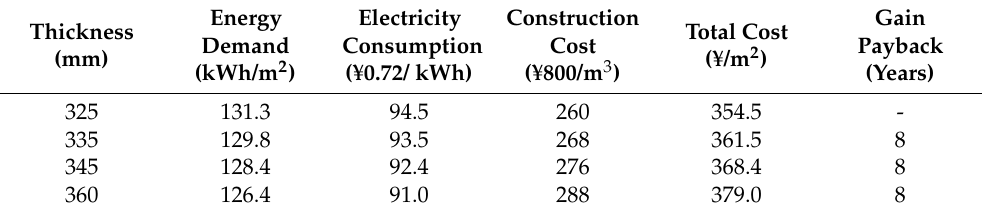
Table 7. Economic Analysis of Energy Consumption and